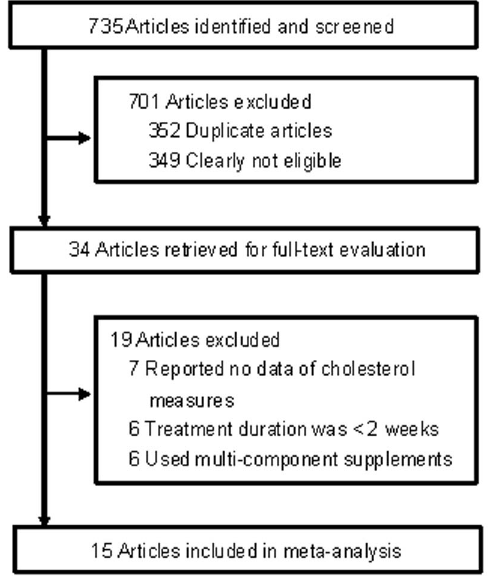
Figure 1. Flow diagram showing the number of studies screened, assessed for eligibility, and included in the meta- analysis.